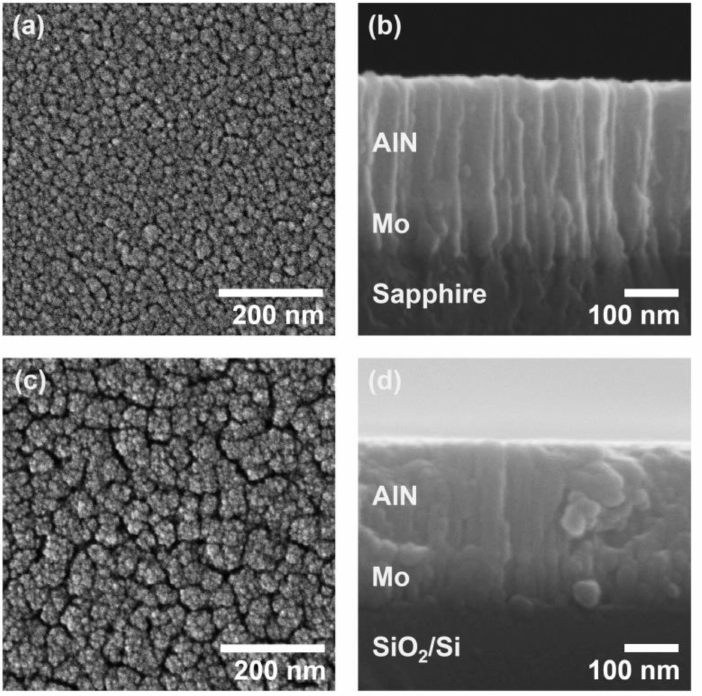
Figure 5. Scanning electron microscopy (SEM) images of the AlN thin film. ( a ) Top-view and ( b ) cross- sectional view of the AlN thin film on the Mo/sapphire substrate. ( c ) Top-view and ( d ) cross-sectional view of the AlN thin film on the Mo/SiO 2 /Si